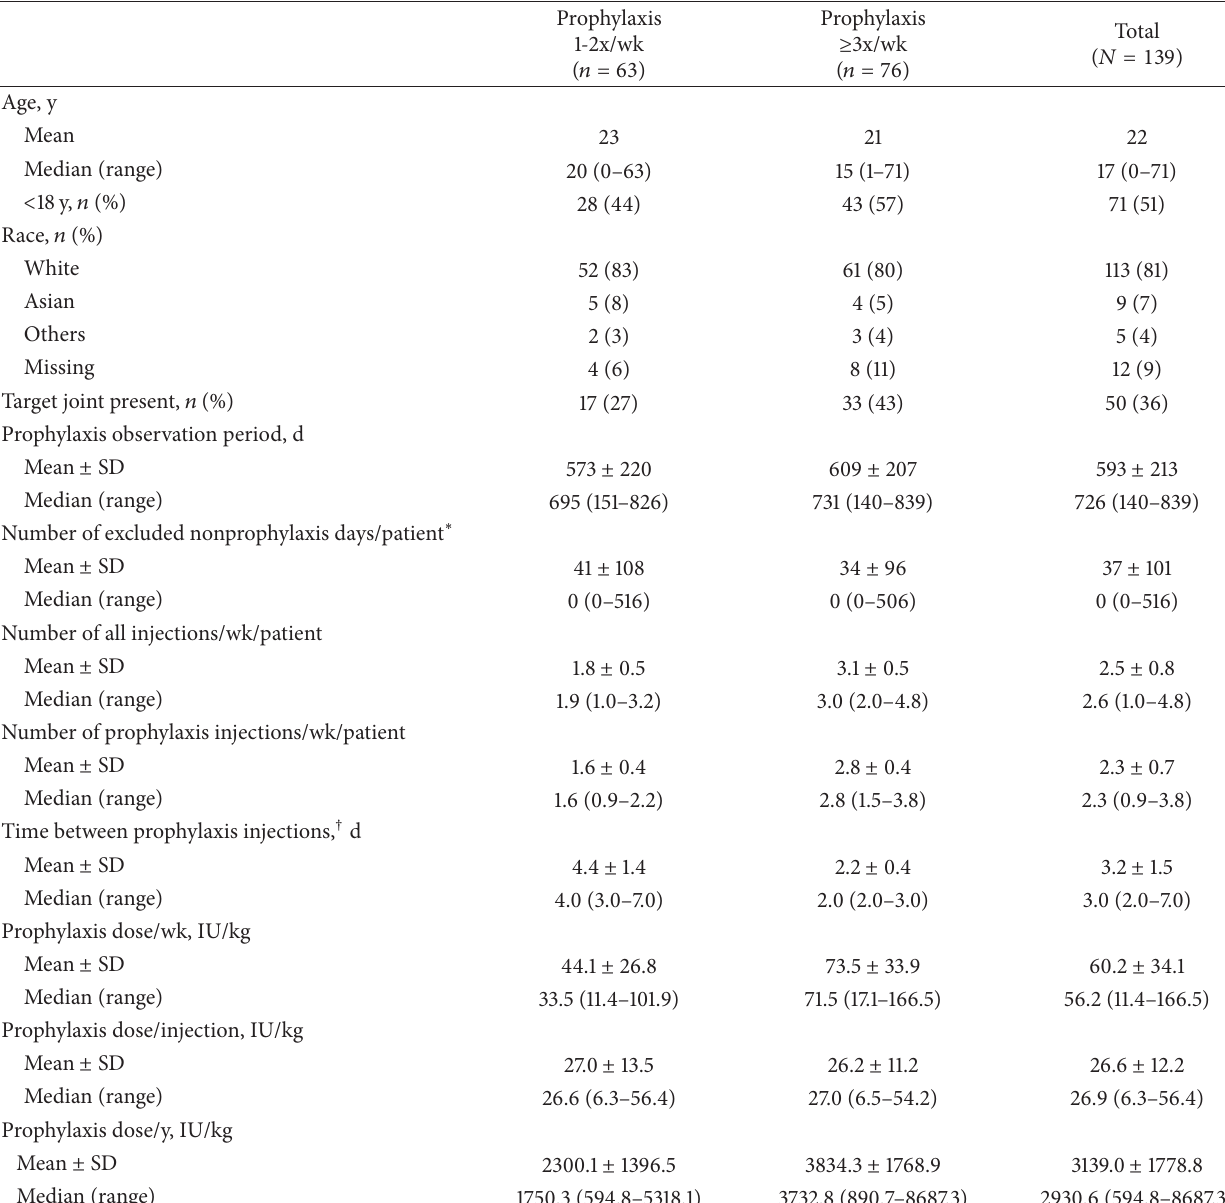
Table 1: Demographic and dosing